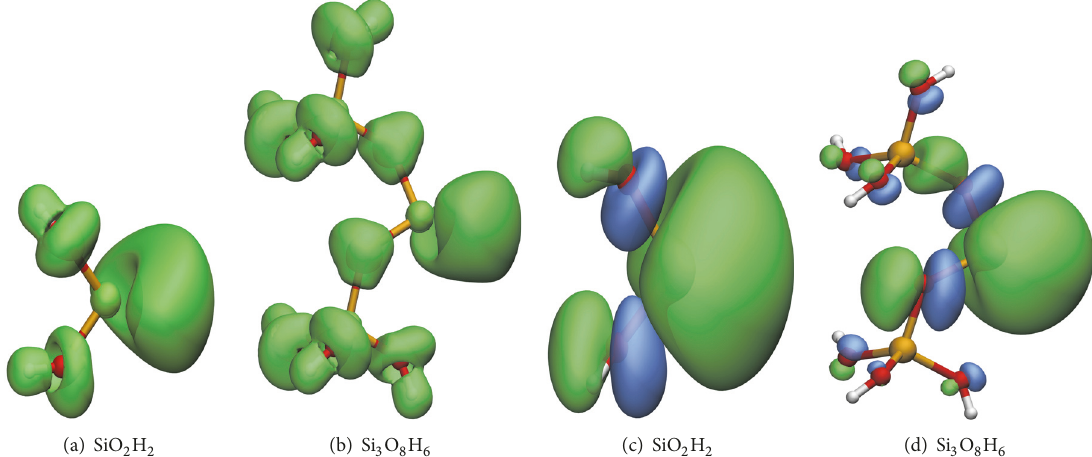
Figure 7: (a)-(b) ELF of the divalent Si in 𝛼 -quartz cluster configurations with ODC(II). (c)-(d) Orbital wave function of HOMO in 𝛼 -quartz cluster configurations with ODC(II). Green and blue color represent positive and negative phase of the orbital wave function, respectively.